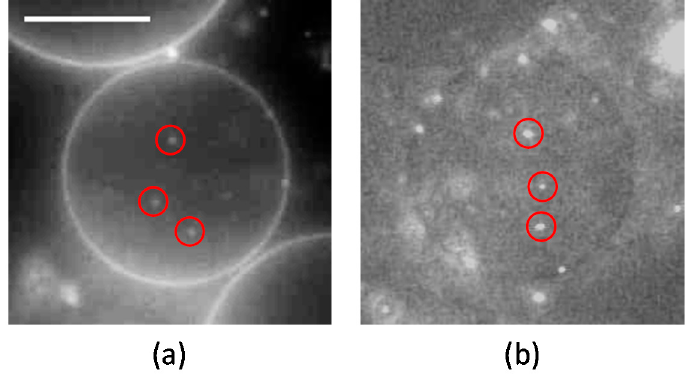
Figure 2. Microscopic images of ( a ) fluorescent lipid rho-DHPE (N-(rhodamine red-X)-1,2-dihexadecanoyl-sn-glycero-3-phosphoethanolamine triethylammonium salt) and ( b ) YG-particle fluorescence. The red circles indicate penetrated particles. Scale bar is 10 µm.